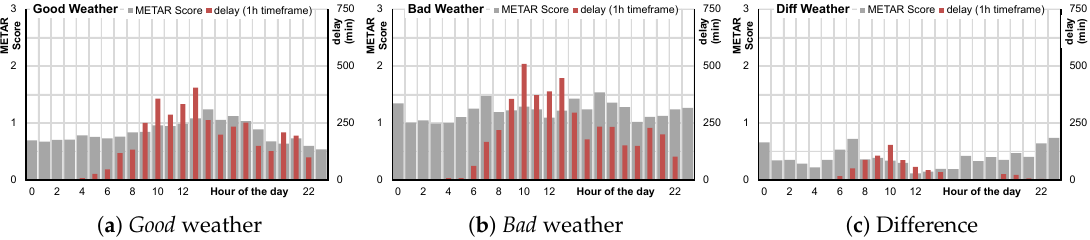
Figure 7. Categorization of weather days, separated by the common ATMAP score 1.5 to distinguish between ( a ) good and ( b ) bad weather conditions; ( c ) indicates the differences between.